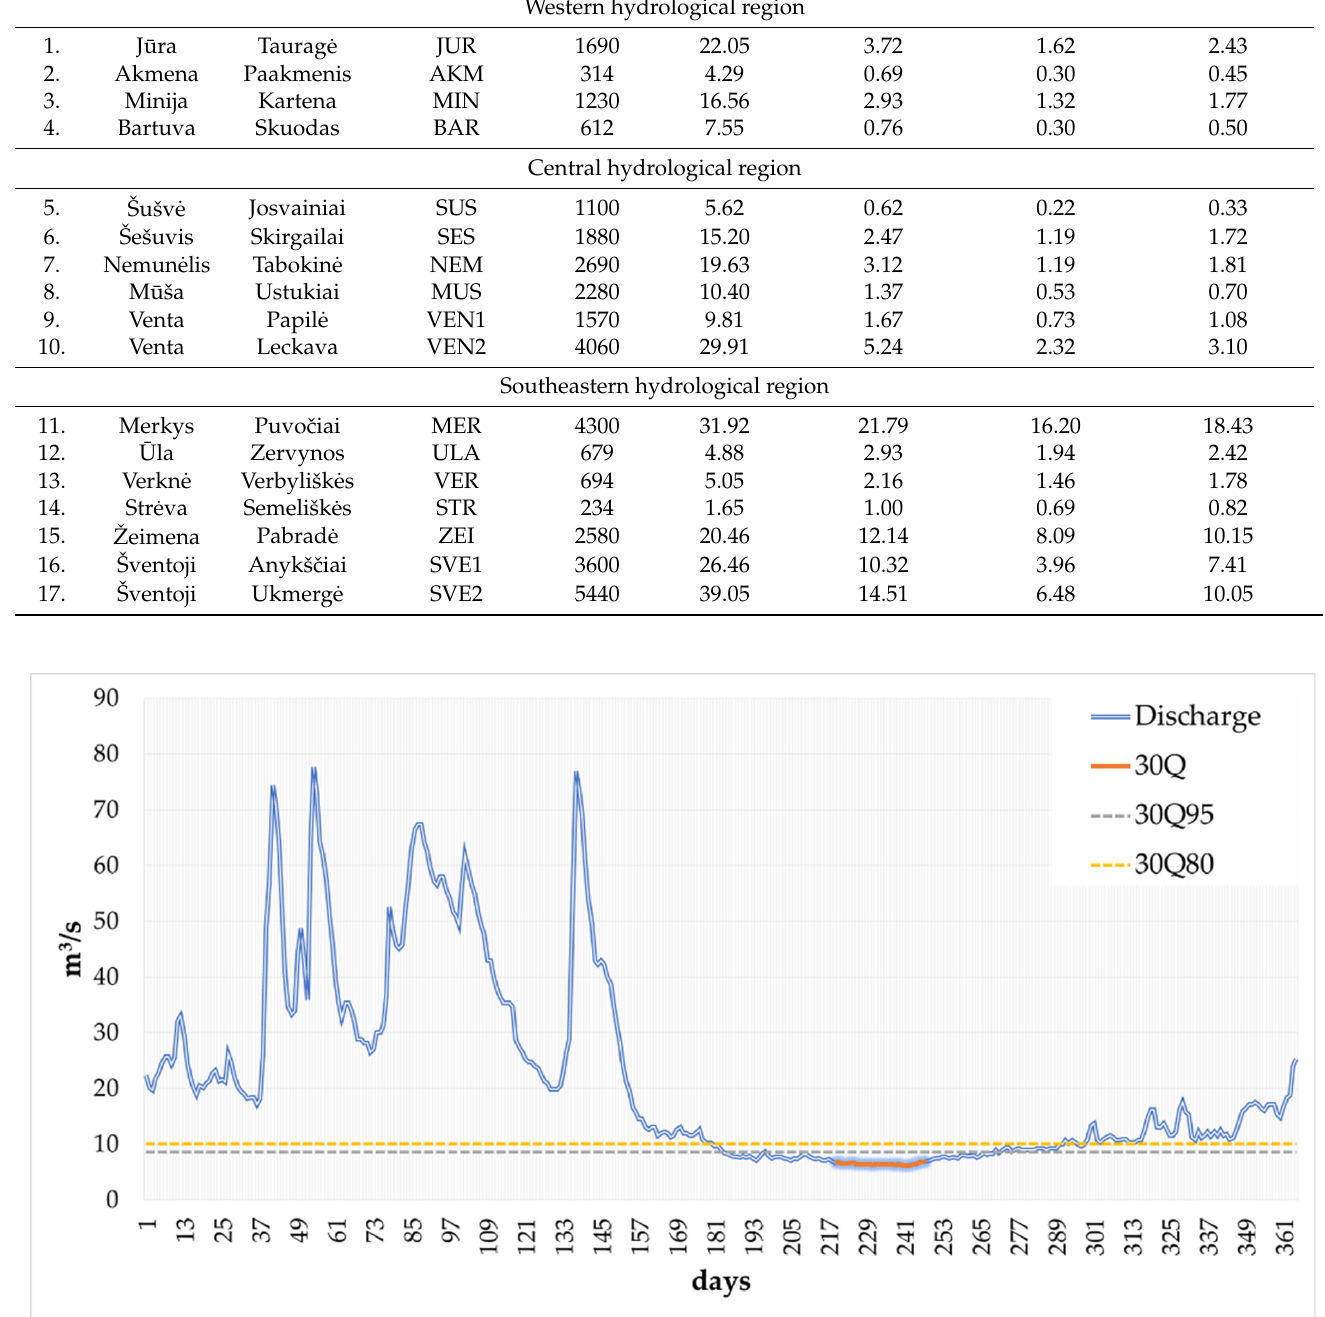
Figure 2. Low flow indices (example of the Šventoji at Ukmerg ė WGS in 1973). Maps were created in ArcGIS 10.4 using the Kriging interpolation method (Spatial Low flows were calculated for the periods of 1961–2020, 1961–1990, and 1991–2020. Analyst toolbox). Kriging assumes that the distance or direction between sample points reflects a spatial correlation that can be used to explain variation in the surface. The Kriging tool fits a mathematical function to a specified number of points, or all within a